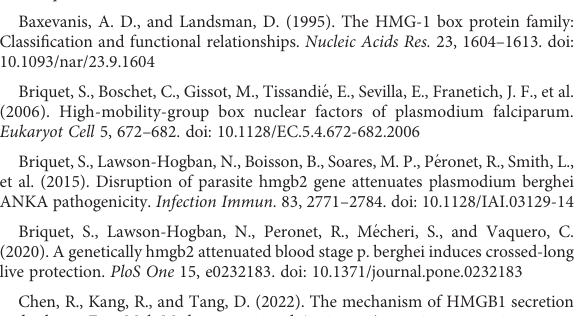
SUPPLEMENTARY FIGURE 1 Con fi rmation of HMGB2 deletion. The cDNA was prepared from WT and Pfhmgb2¯ clone 8D parasites and PCRs were performed using the oligonucleotides designed from HMGB2 open reading frame (ORF) and control 18s rRNA oligonucleotides. The band sizes for different set of PCRs are